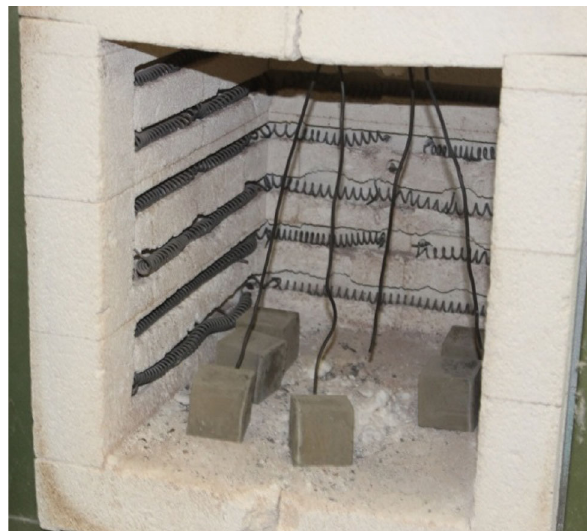
Fig. 1 Locally manufactured kiln to heat the geopolymer composite specimens at various elevated